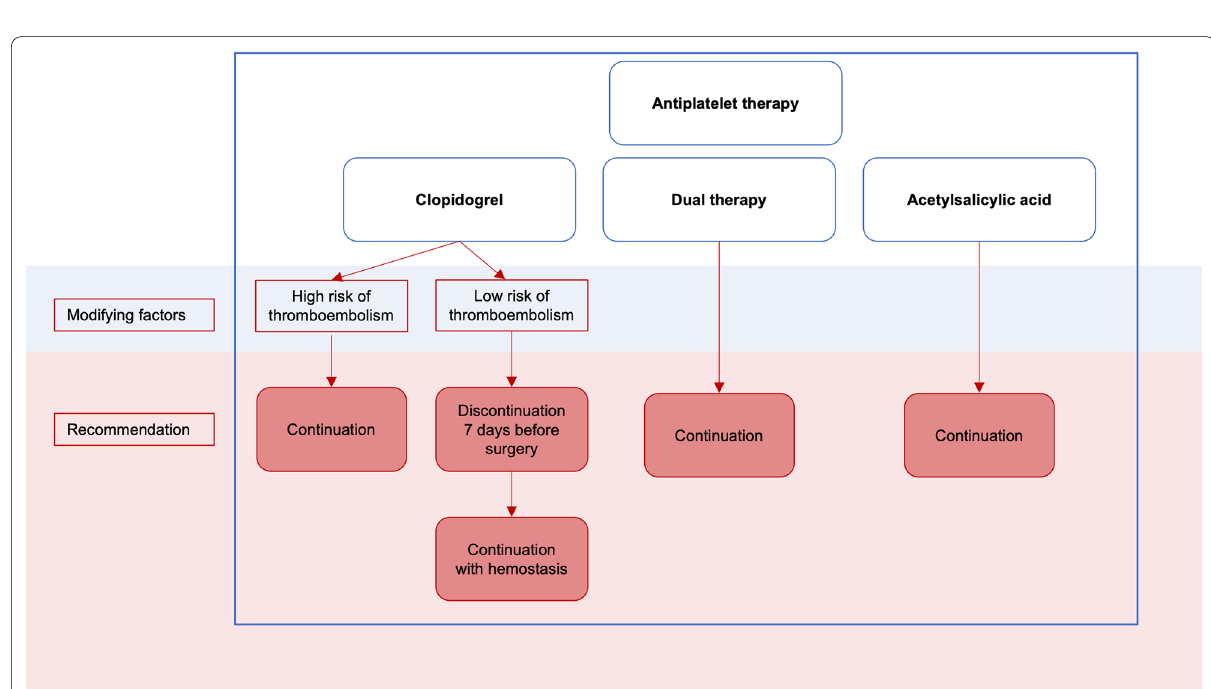
Fig. 7 Clinical recommendations for oral surgery in patients treated with antiplatelet